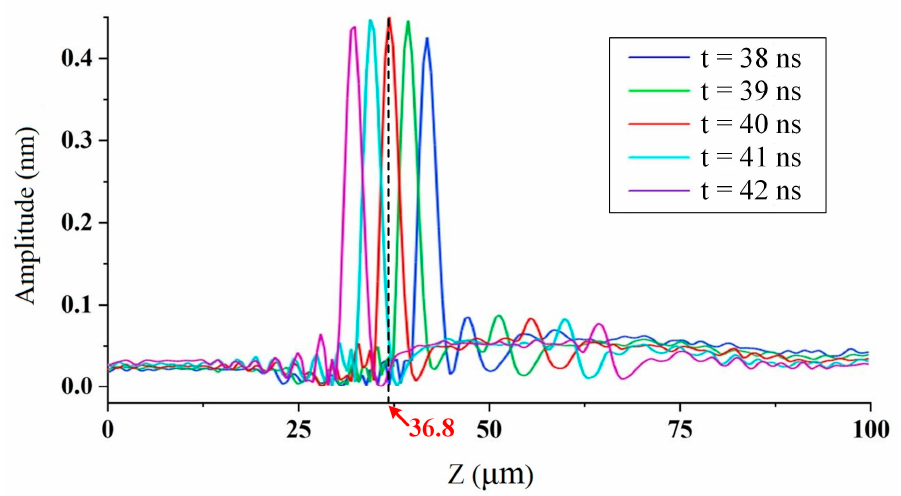
Figure 7. Amplitudes of the shear wave along the central axis near the focus